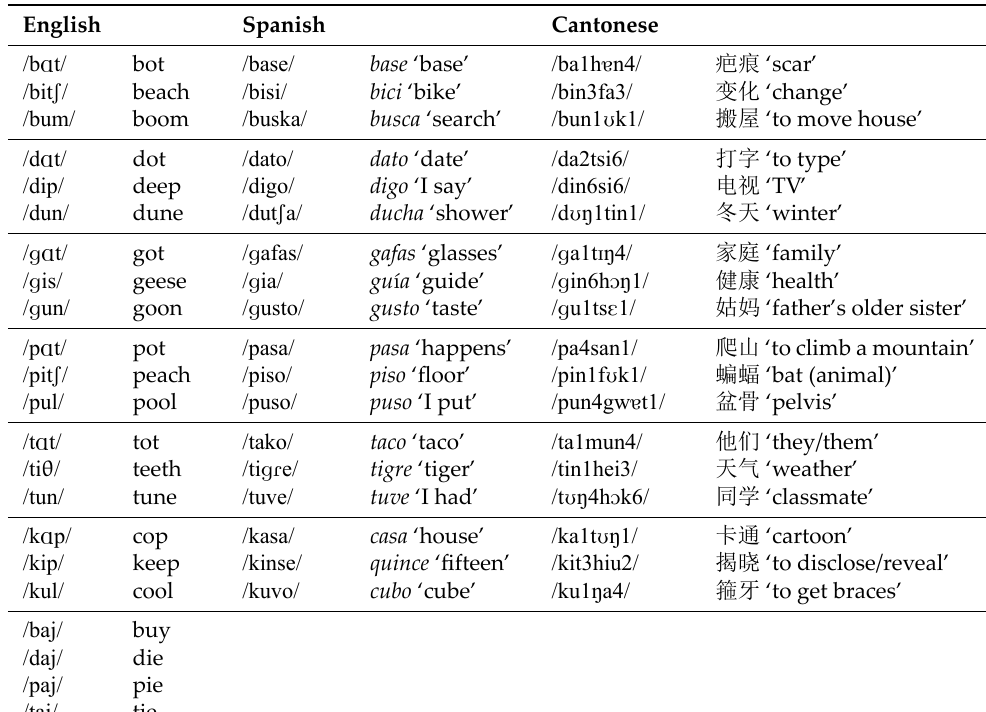
Table A1. Stimuli for baseline word reading task. For Cantonese, only simplified characters are shown here, but participants had a choice to see simplified or traditional